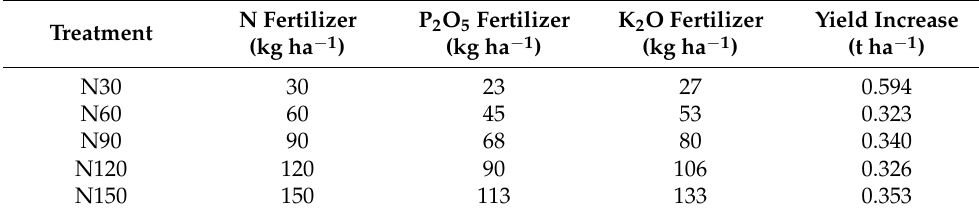
Table 3. Data of treatments and expectable grain yield increase.